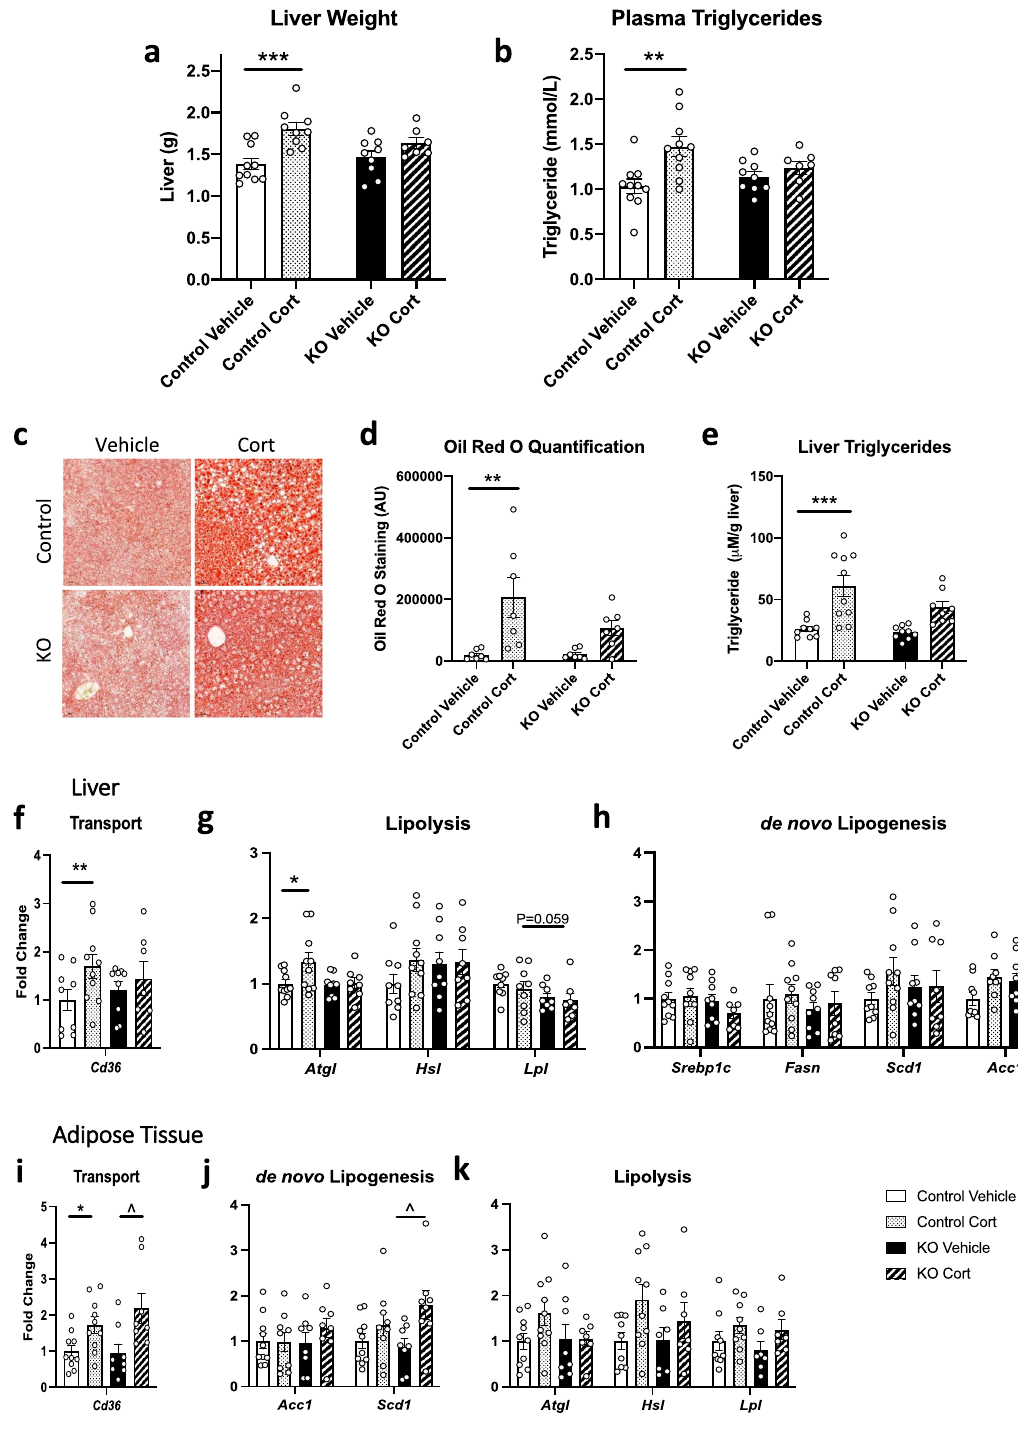
Figure 3. Female AgRP-GR KO mice are partially protected from corticosterone (Cort)-induced hepatic steatosis. ( a ) Liver weight, ( b ) plasma triglycerides, ( c ) representative images of Oil Red O staining, ( d ) quantification of Oil Red O staining, ( e ) liver triglycerides, mRNA expression in liver of ( f ) Cd36 , a fatty acid transport gene, ( g ) lipolysis genes and ( h ) de novo lipogenesis genes. Adipose mRNA expression of ( i ) Cd36 , a fatty acid transport gene, ( j ) de novo lipogenesis and ( k ) lipolysis genes. All mice were treated with vehicle or Cort in drinking for 3 weeks. ( a ) and ( b ) n = 7–10, Two-way ANOVA with Tukey Multiple Comparison test, ( d ) n = 7, 30 images per animal analysed, Two-way ANOVA with Tukey Multiple Comparison test. ( e ) n = 8–10, Two-way ANOVA with Tukey Multiple Comparison test, ( f – k ) n = 7–10, Mann–Whitney non-parametric t-tests. * P < 0.01, ** P < 0.01, *** P < 0.001 control vehicle versus Cort, ^ P < 0.05 KO vehicle versus